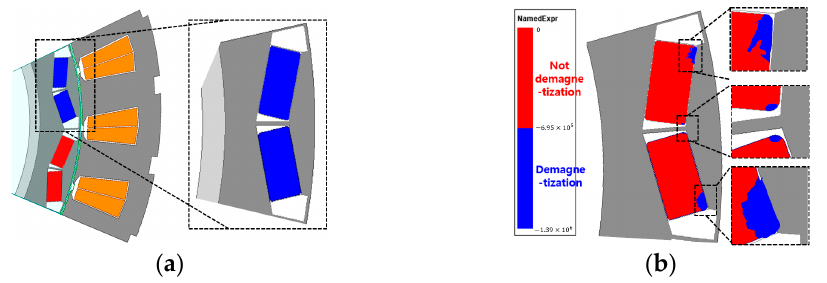
Figure 7. Basic model and its irreversible demagnetization area: ( a ) Basic model, ( b ) Irreversible demagnetization area.